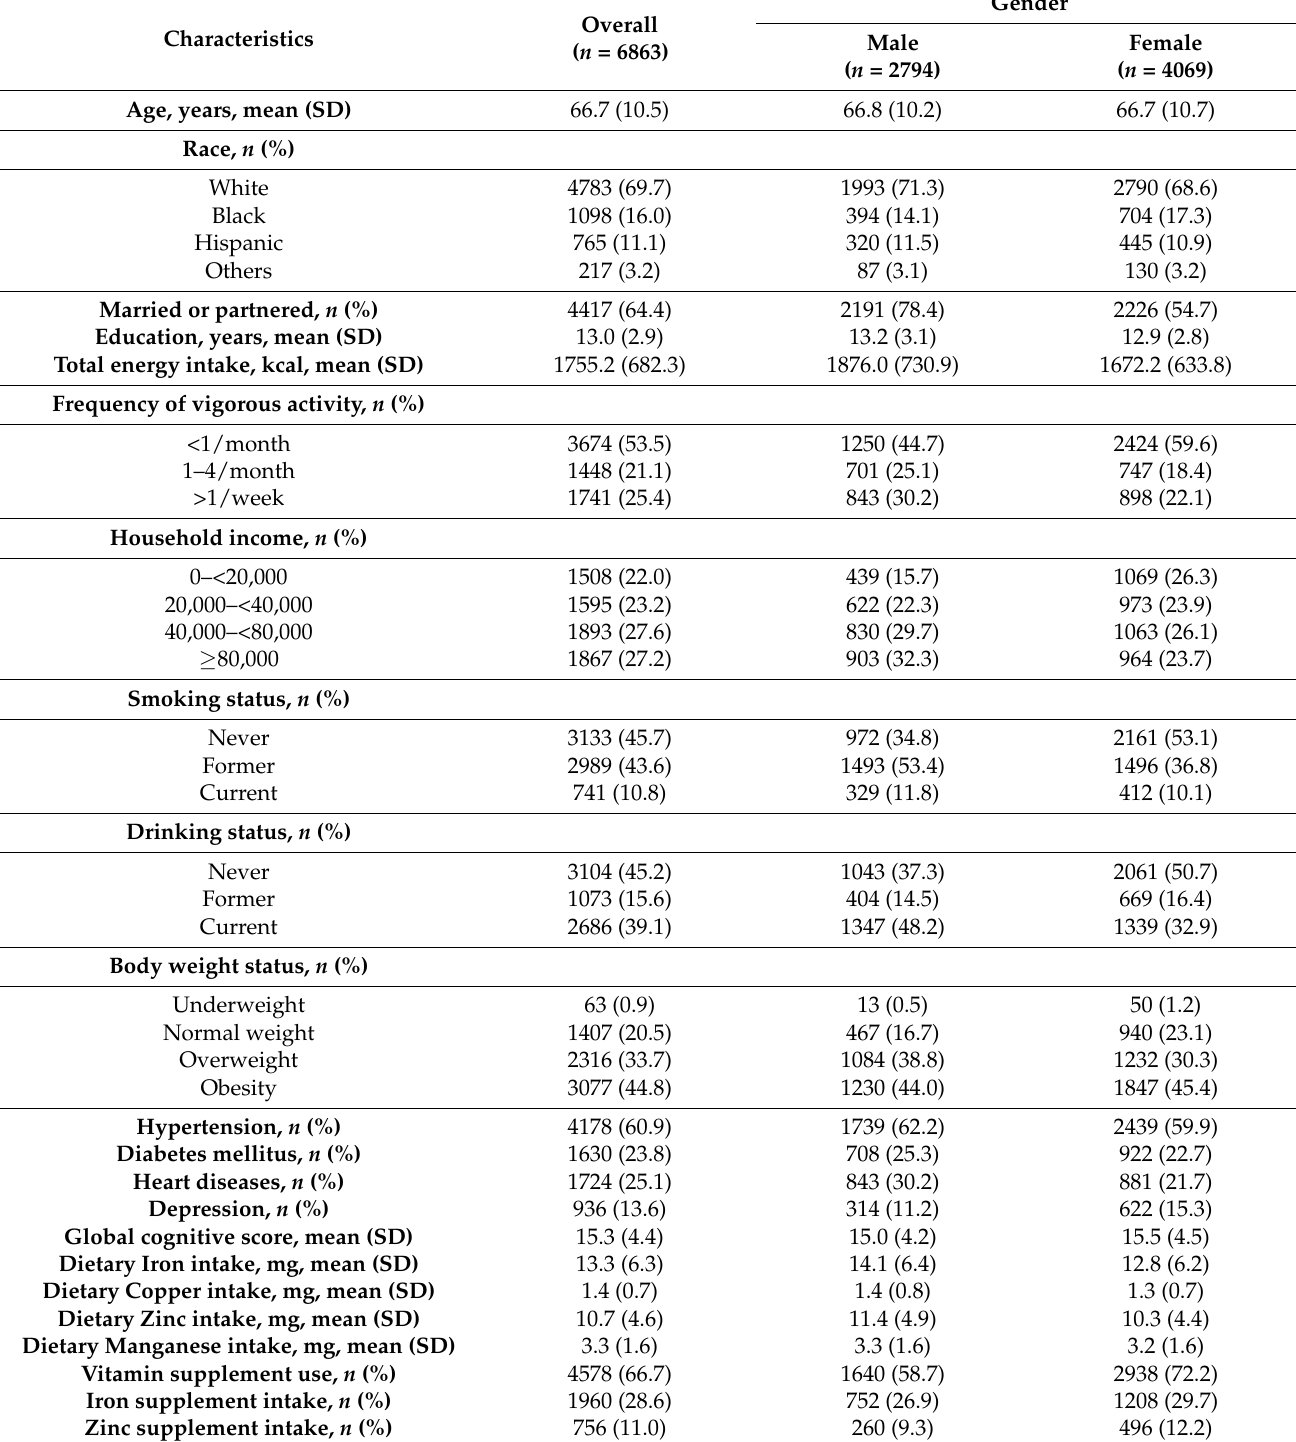
Table 1. Characteristics of the study participants in the Health and Retirement Study in